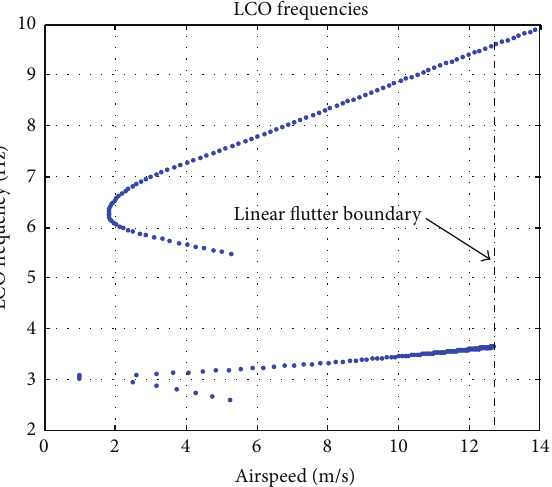
Figure 9: LCO frequencies obtained from the